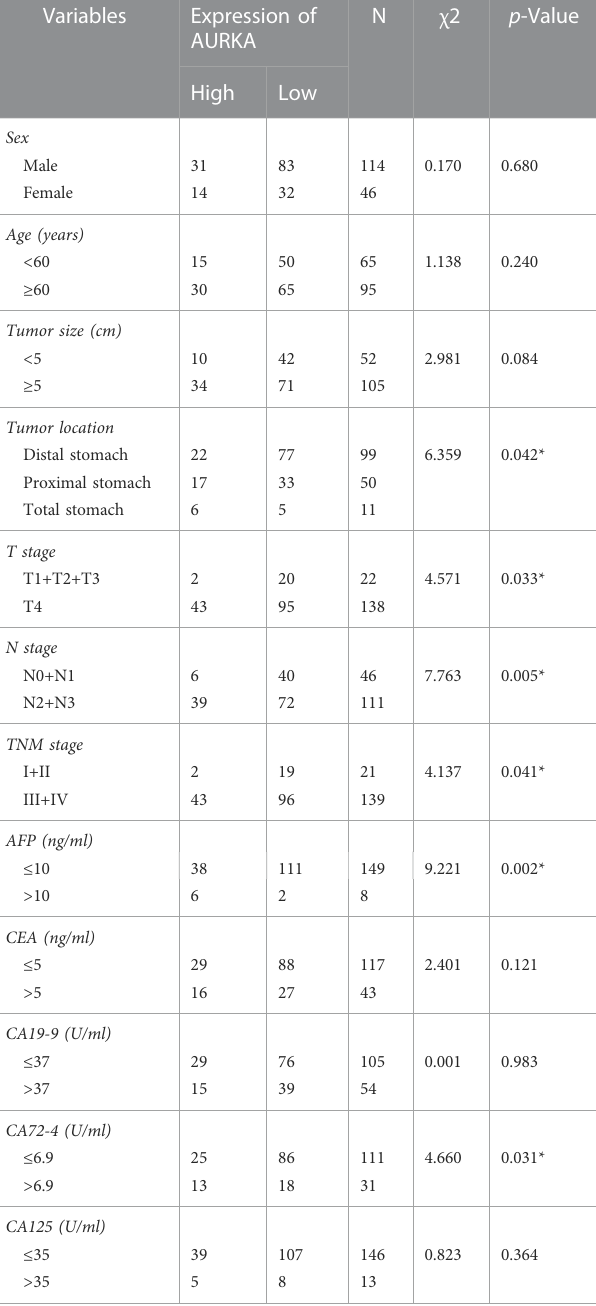
TABLE 1 Relationship between AURKA expression and clinicopathological variables in 160 GC patients.